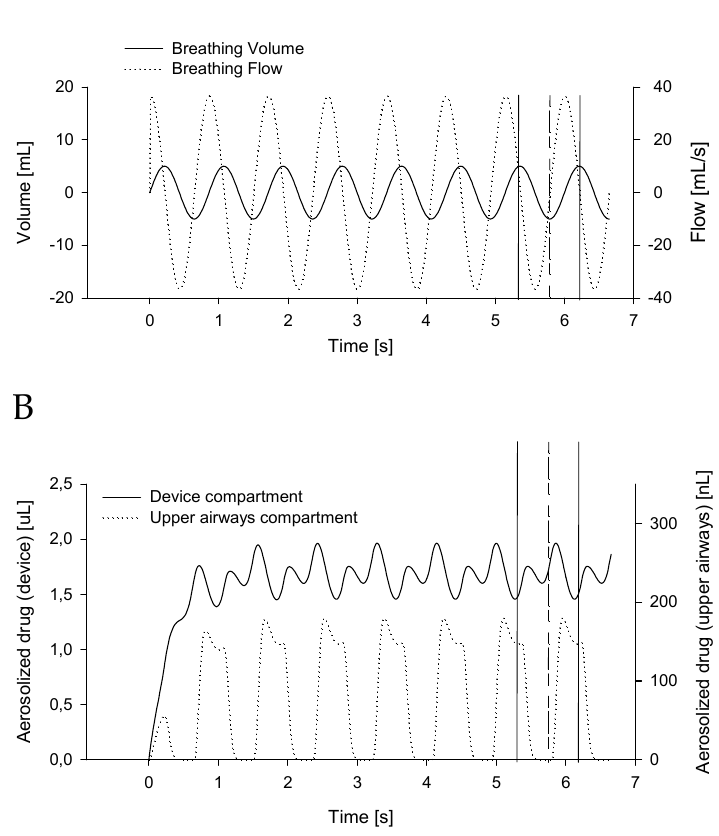
Figure 2. ( A ) Breathing volume and flow time courses fed to the model case (Table 1, Simulation 1). ( B ) Amount of aerosolized drug in the device compartment and the upper airways compartment. Vertical lines highlight, respectively, end inspiration, end expiration, and end inspiration again.